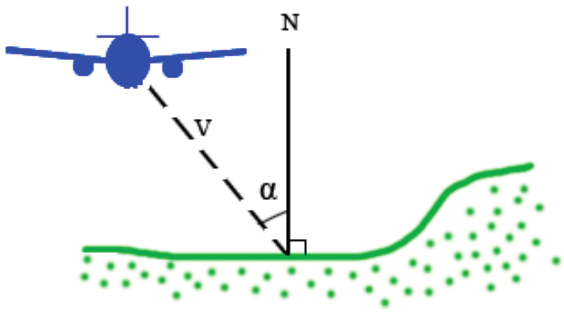
Figure 1. Definition of the incidence angle as the angle between the scan direction and vertical relative to a plane tangent to the local illuminated